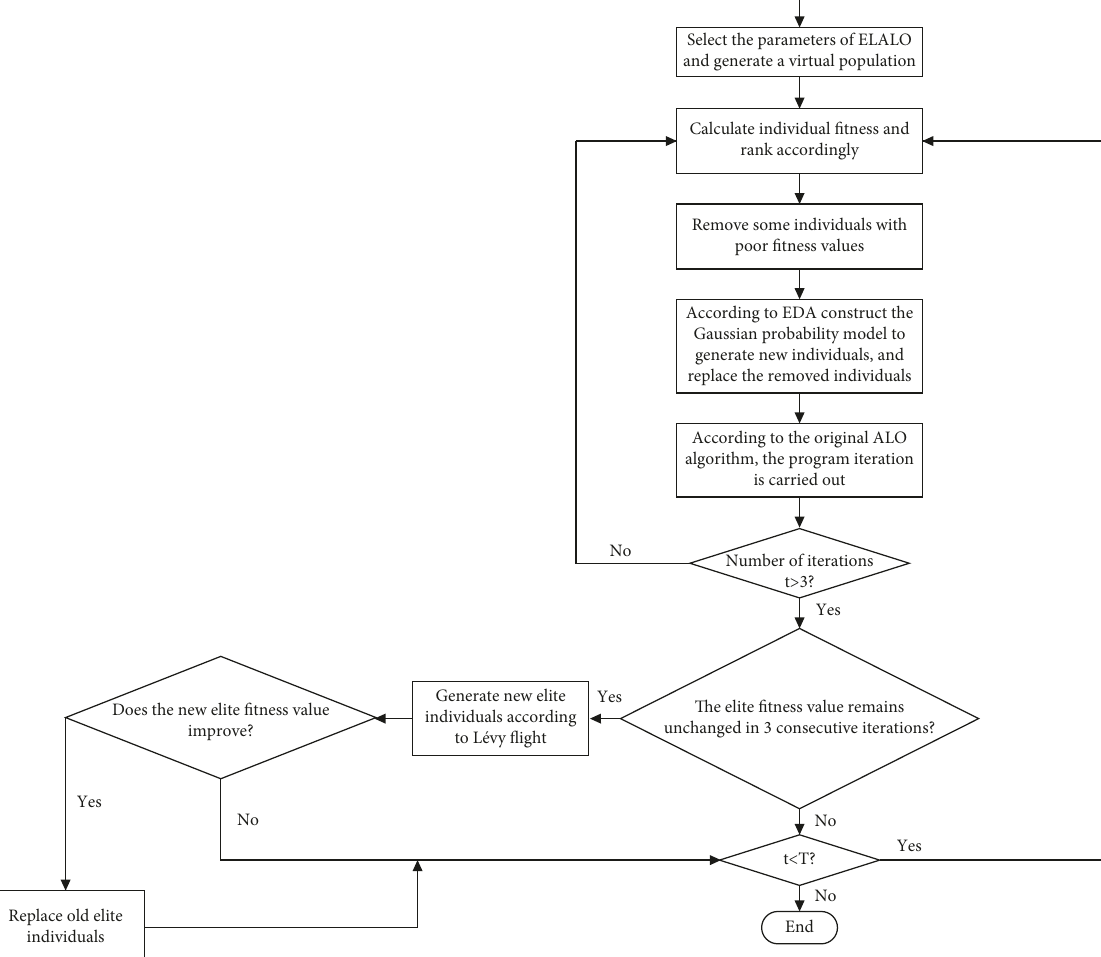
Figure 4: Flow chart of ELALO